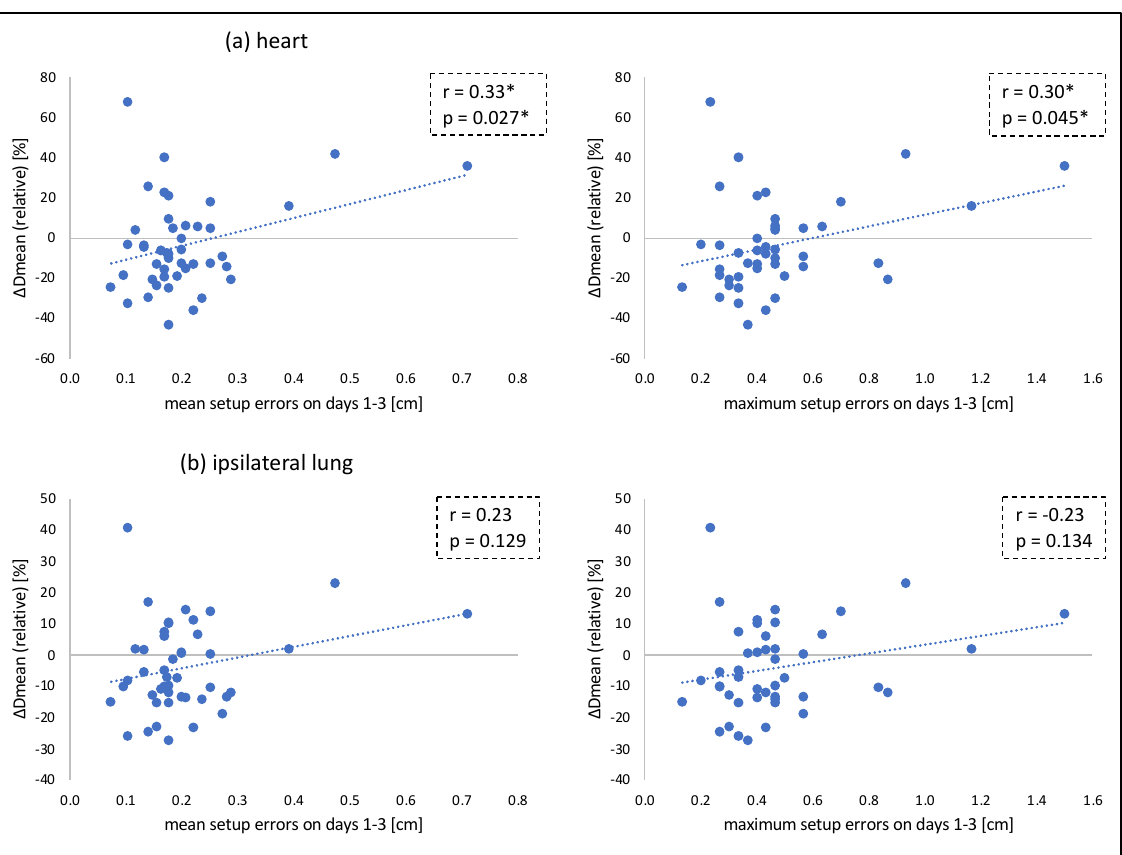
Table 2. Correlation analysis for OAR exposure and setup errors on days 1–3.